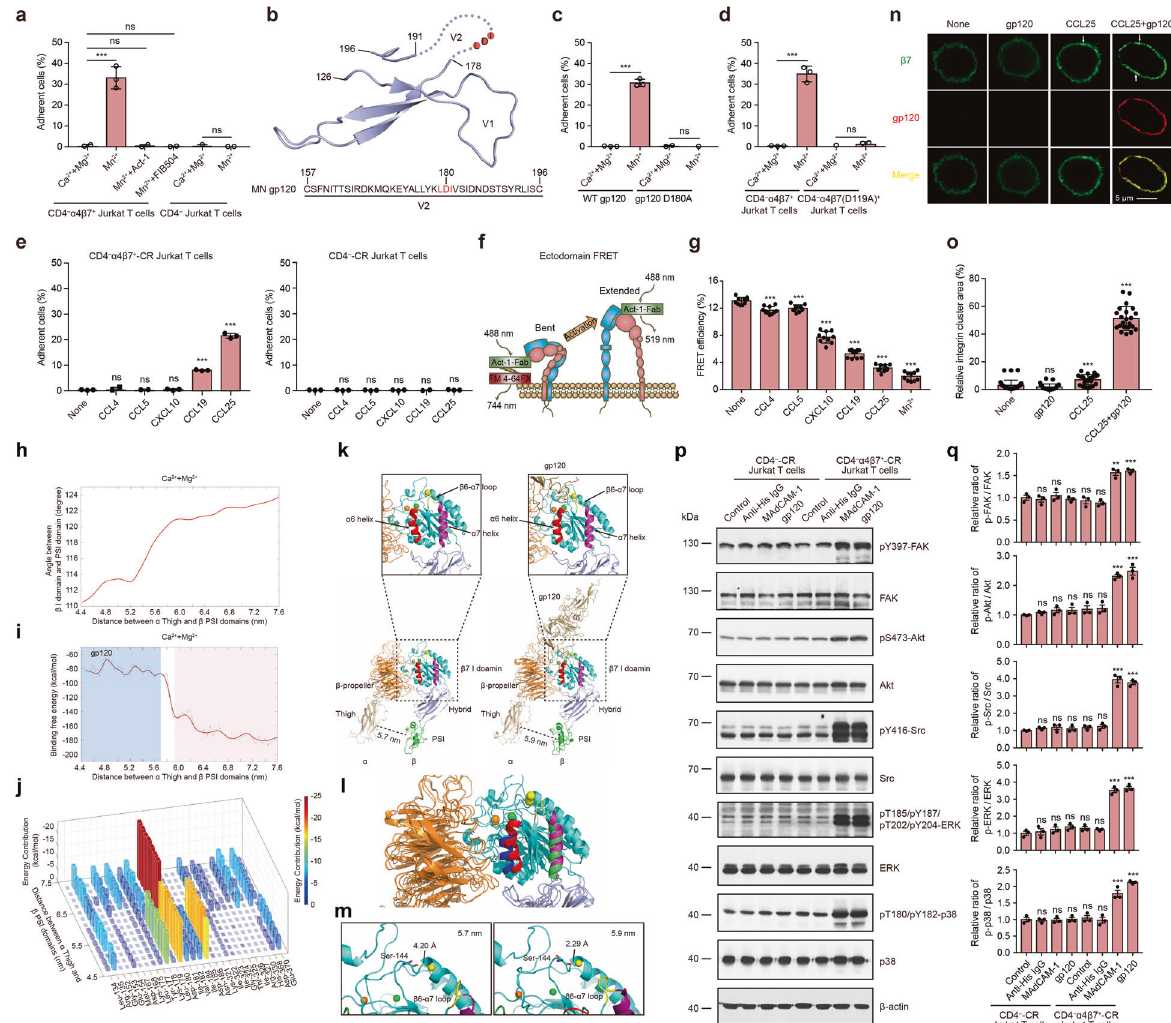
Fig. 1 Distinct chemokines selectively induce HIV-1 gp120-integrin α 4 β 7 binding via triggering conformer-speci fi c activation of α 4 β 7. a Adhesion of CD4 ‒ Jurkat T cells or CD4 ‒ α 4 β 7 + Jurkat T cells to immobilized gp120 in 1 mM Ca 2 + /Mg 2 + or 0.5 mM Mn 2 + . b A diagram of the V1 and V2 domains of gp120 was drawn based on the crystal structure of BG505 SOSIP.664 gp120 (PDB: 3J5M). Light red shadow indicates integrin α 4 β 7 binding site in the V2 loop. Dashed lines indicate the location of gp120 V2 loop. The sequence of the V2 domain of MN gp120 was provided at the bottom and the potential integrin α 4 β 7 binding motif in gp120 is highlighted in red. c Adhesion of CD4 ‒ α 4 β 7 + Jurkat T cells to the immobilized gp120 or gp120 D180A in 1 mM Ca 2 + /Mg 2 + or 0.5 mM Mn 2 + . d Adhesion of CD4 ‒ α 4 β 7 + Jurkat T cells and CD4 ‒ α 4 β 7 (D119A) + Jurkat T cells to immobilized gp120 in 1 mM Ca 2 + /Mg 2 + or 0.5 mM Mn 2 + . e Adhesion of CD4 ‒ -CR Jurkat T cells or CD4 ‒ α 4 β 7 + -CR Jurkat T cells to the immobilized gp120 in 1 mM Ca 2 + /Mg 2 + with and without chemokine stimulation. f Experiment setup for measuring FRET ef fi ciency between integrin α 4 β 7 β I domain and the plasma membrane (Ectodomain FRET). A composite of all molecules used is depicted. g FRET ef fi ciency of CD4 ‒ α 4 β 7 + -CR Jurkat T cells before and after treatment with 0.5 μ g/ml chemokines or 0.5 mM Mn 2 + . h Relationship of the distance between integrin α Thigh and β PSI domains and the angle between β I domain and PSI domain in Ca 2 + /Mg 2 + . i Binding free energy pro fi les of integrin α 4 β 7 headpiece to gp120 in Ca 2 + /Mg 2 + during the conformational transition. j Per-residue free energy decomposition of the residues at the interface of integrin α 4 β 7 headpiece and gp120 complex from the MM/GBSA. The residues of gp120 with energy contributions stronger than − 1 kcal/mol along the conformational path of α 4 β 7 headpiece are illustrated. The color bar is set in the range of − 25 – 0 kcal/mol. k Snapshot of integrin α 4 β 7 headpiece with a distance of 5.7 or 5.9 nm between α 4 Thigh and β 7 PSI domains. The α 6 and α 7 helices of the β 7 I domain are colored in red and purple, and SyMBS, MIDAS, and ADMIDAS metal ions are colored in orange, green, and yellow spheres, respectively. l Superposition of integrin α 4 β 7 headpiece with a distance of 5.7 or 5.9 nm between α 4 Thigh and β 7 PSI domains. The α 6 and α 7 helices of the β 7 I domain were shown in red and purple in 5.7 nm structure, and in blue and green in 5.9 nm structure. m The change of the distance of ADMIDAS metal ion to the backbone carbonyl of Ser-144 located at β 1- α 1 loop region and the movement of the β 6- α 7 loop (yellow colored) during the transition from 5.7 to 5.9 nm between α 4 Thigh and β 7 PSI domains. n Confocal microscopy visualization of the integrin clustering on the plasma membrane of CD4 ‒ α 4 β 7 + -CR Jurkat T cells. Integrin β 7, green; gp120, red. White arrowheads indicate the representative integrin clusters. Scale bar, 5 μ m. o The relative integrin cluster area was calculated as the percentage of the fl uorescence intensity of integrin clusters in relation to that of the entire cell surface. p , q CD4 ‒ -CR Jurkat T cells or CD4 ‒ α 4 β 7 + -CR Jurkat T cells were pre-treated with CCL25 (0.5 μ g/ml, in HBS with 1 mM Ca 2 + /Mg 2 + ) for 15 min at room temperature. Then cells were stimulated with anti-His IgG (100 μ g/ml), MAdCAM-1 (100 μ g/ml) or gp120 (500 μ g/ml) for 30 min at 37 °C, respectively. The expression and phosphorylation of FAK, Akt, Src, ERK, and p38 were determined by immunoblot analysis ( p ). The relative ratios of p-FAK/FAK, p-Akt/Akt, p-Src/Src, p-ERK/ERK, and p-p38/p38 were normalized to the values of CD4 ‒ -CR Jurkat T cells without stimulation (Control) ( q )